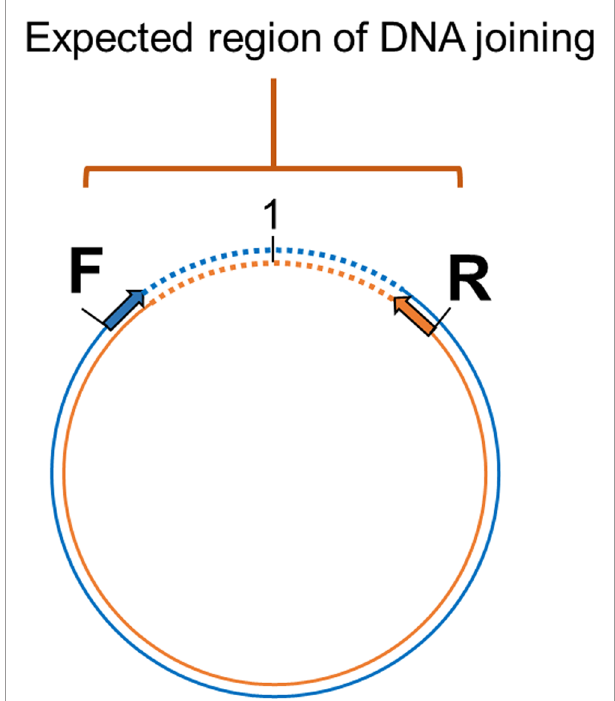
FIGURE 2 | Diagram showing the method to prove circular DNA forms of IHHNV-cvcDNA by PCR ampli fi cation using outward-facing forward and reverse primers indicate the designed primers regions base on assembled linear nucleotide sequences derived from the putative cvcDNA sequencing. Single step PCR ampli fi cation was carried out using puri fi ed cvcDNA as a template. The occurrence of positive PCR amplicons indicated closure of circular DNA including the nucleotide sequences for the end-joining